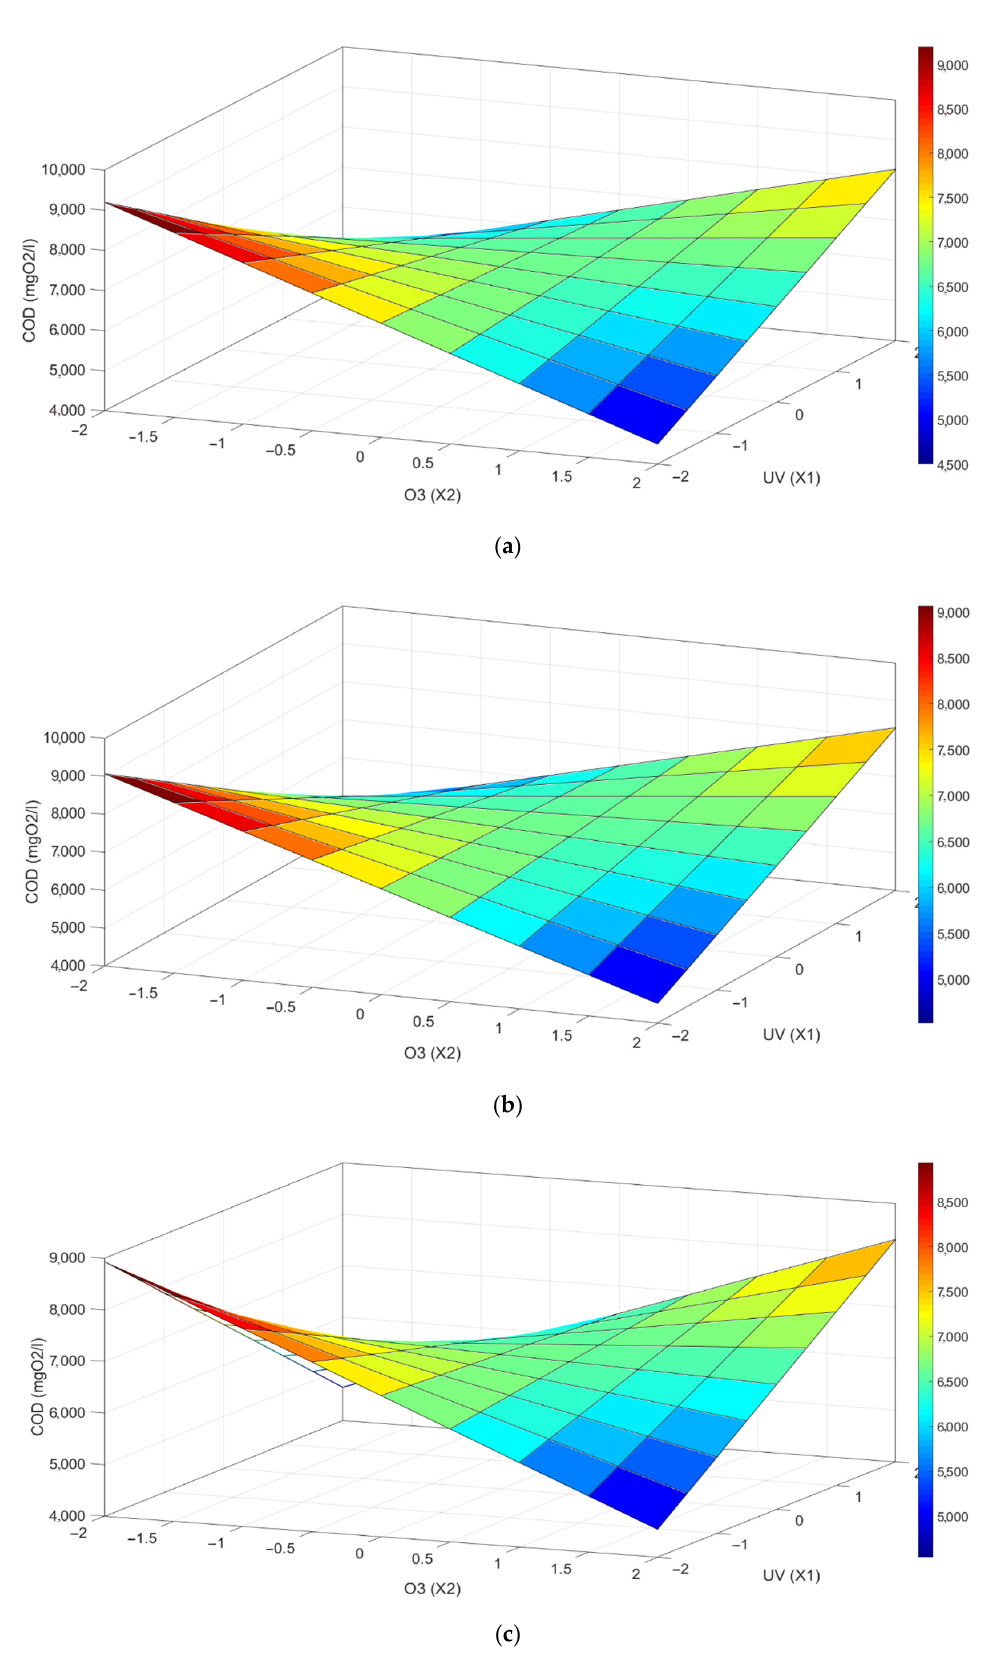
Figure 7. 3D plots of response surface graphs for the combined effect of H 2 O 2 , O 3 , and UV on COD removal. ( a ) H 2 O 2 (X 3 ) = − 1, ( b ) H 2 O 2 (X 3 ) = 0, and ( c ) H 2 O 2 (X 3 ) =